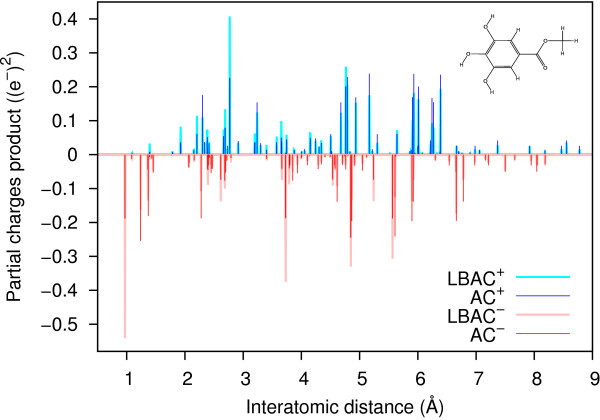
Autocorrelogram. In blue and red impulses: positive and negative values of the autocorrelation (AC±) of partial charges for the first ligand of the comt target. The ligand is depicted in 2D at the top right. The linearly binned versions (LBAC±) of the positive and negative parts of the autocorrelogram are the cyan and pink lines.